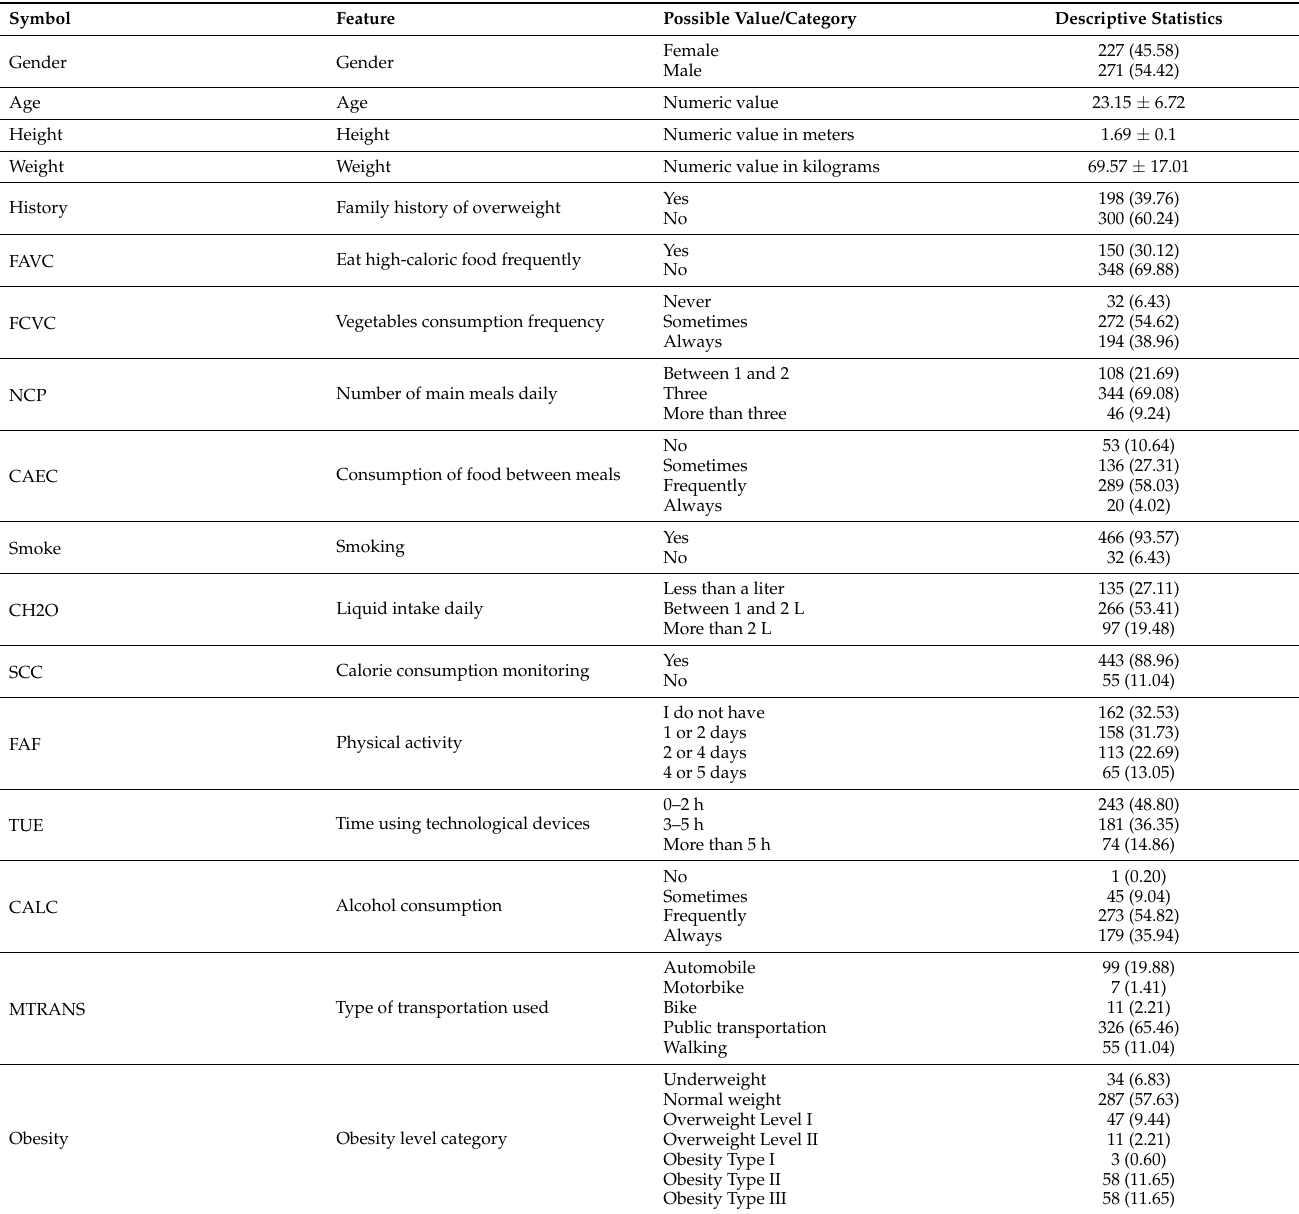
Table 1. Description and values of the features in the dataset related to the obesity